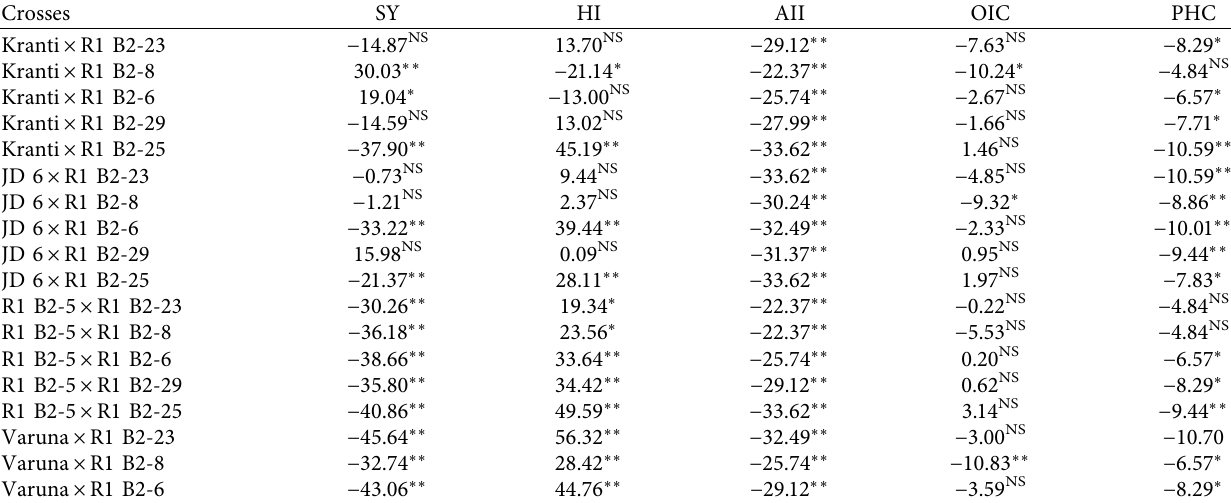
Table 19: Standard (economic) heterosis of mustard hybrids for yield and its attributed traits.